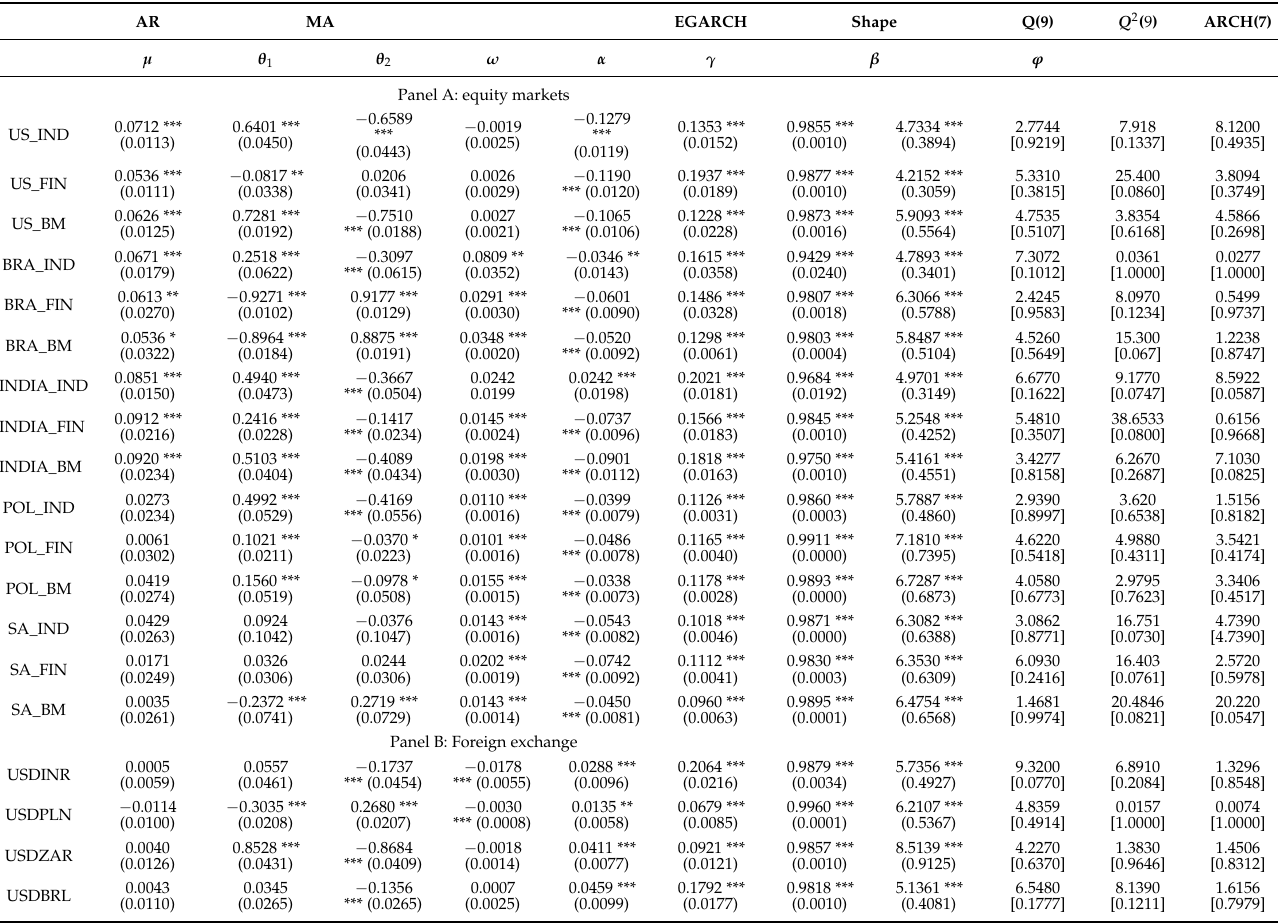
Table 2. ARFIMA (1,0,1) +EGARCH (1,1) estimates for